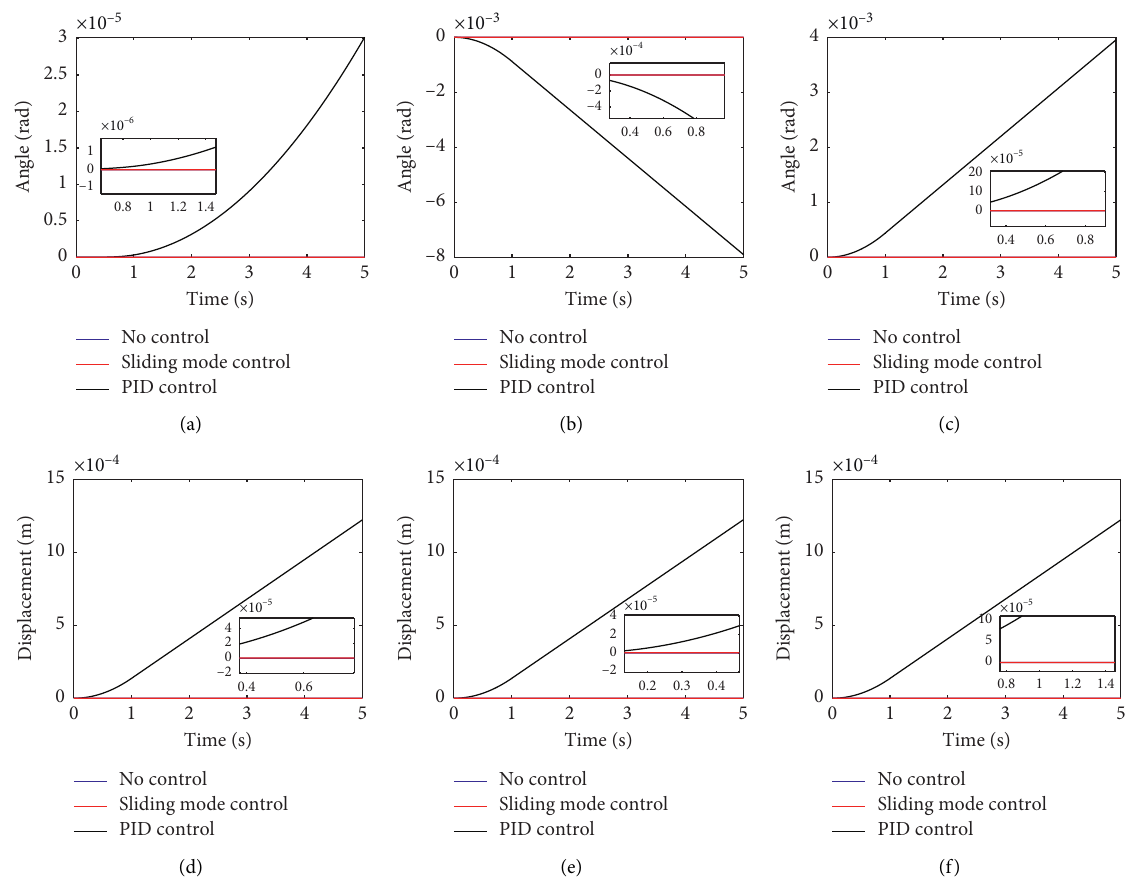
Figure 13: Floating platform displacement and posture control: (a) θ